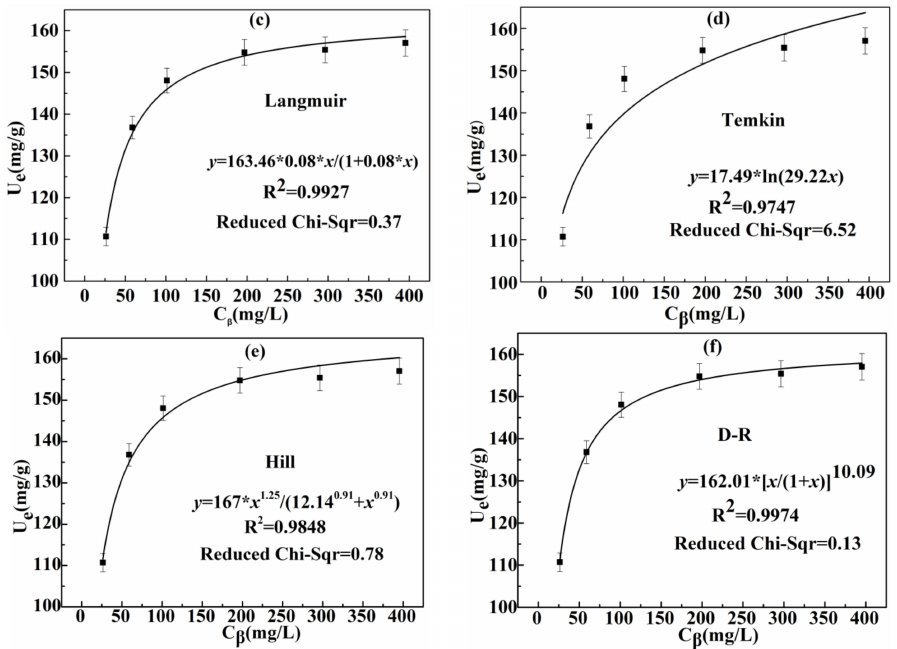
Figure 6. Effect of initial concentration of Ag(I) ( a ), adsorption isotherm, Freundlich ( b ), Langmuir ( c ), Temkin ( d ), Hill ( e ), and D-R ( f